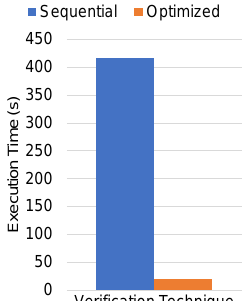
Figure 10. Data verification time with or without parallel processing.